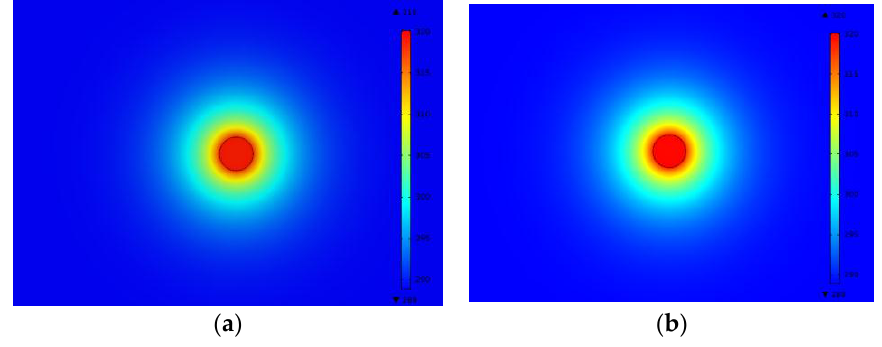
Figure 3. Temperature response after one-month (u = 0 m/s, D/L ratio = 0.025). ( a ) Borehole permeability same as ground); ( b ) Impermeable borehole. Energies 2016 , 9 , 318